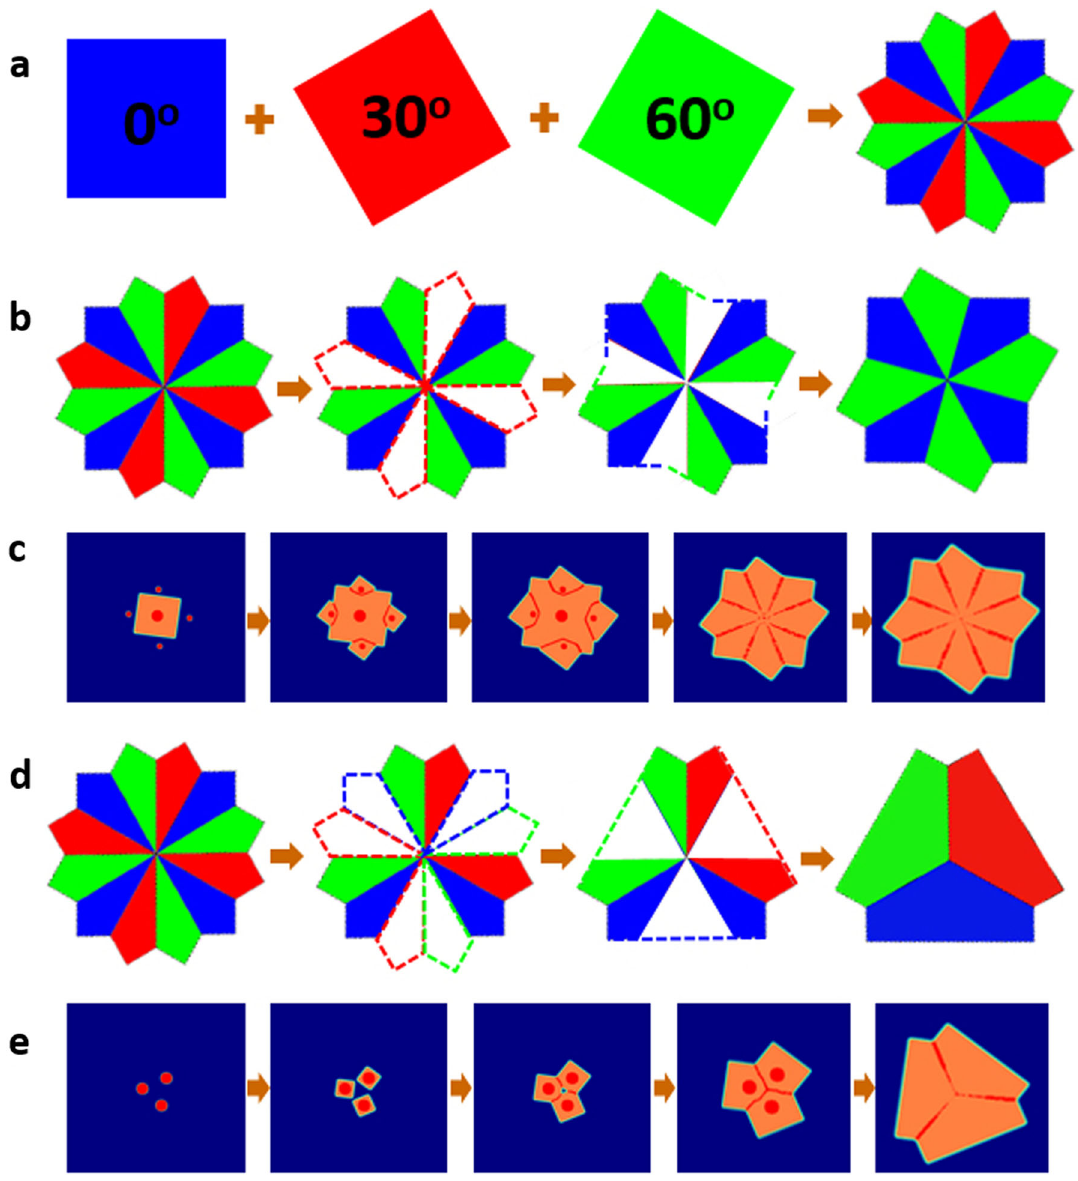
Fig. 8 Formation of steady-state 2D polycrystals from the coalescence of square grains on a three- or six-fold symmetric substrate. a Schematics on the construction of the steady-state polycrystal with the largest number (12) of convex vertices formed from the coalescence of square grains with three different orientations. The relative orientation angle of each grain is provided. b , d Schematics on the construction of the steady-state polycrystalline island with eight and six convex vertices based on the polycrystalline island with 12 convex vertices, respectively. Convex vertices that are chosen to disappear are denoted by dashed outlines in the second panel. c , e PFT simulation showing an example of the formation of a polycrystalline island in ( b , d ), respectively. The fourth and fi fth panels in ( c ) and the fi fth panel in ( e ) are zoomed out for a better